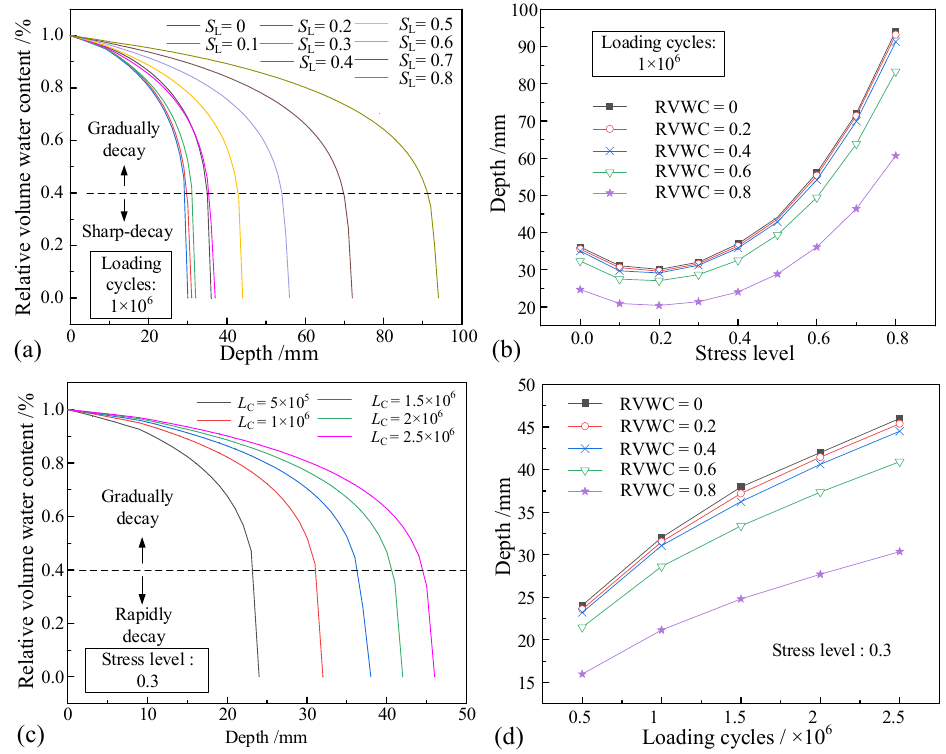
Figure 8. Relative water content distribution ( a ); stress level at 1 × 10 6 loading cycles ( b ); relative volume water content ( c ); and ( d ) loading cycles under 0.3 σ max .